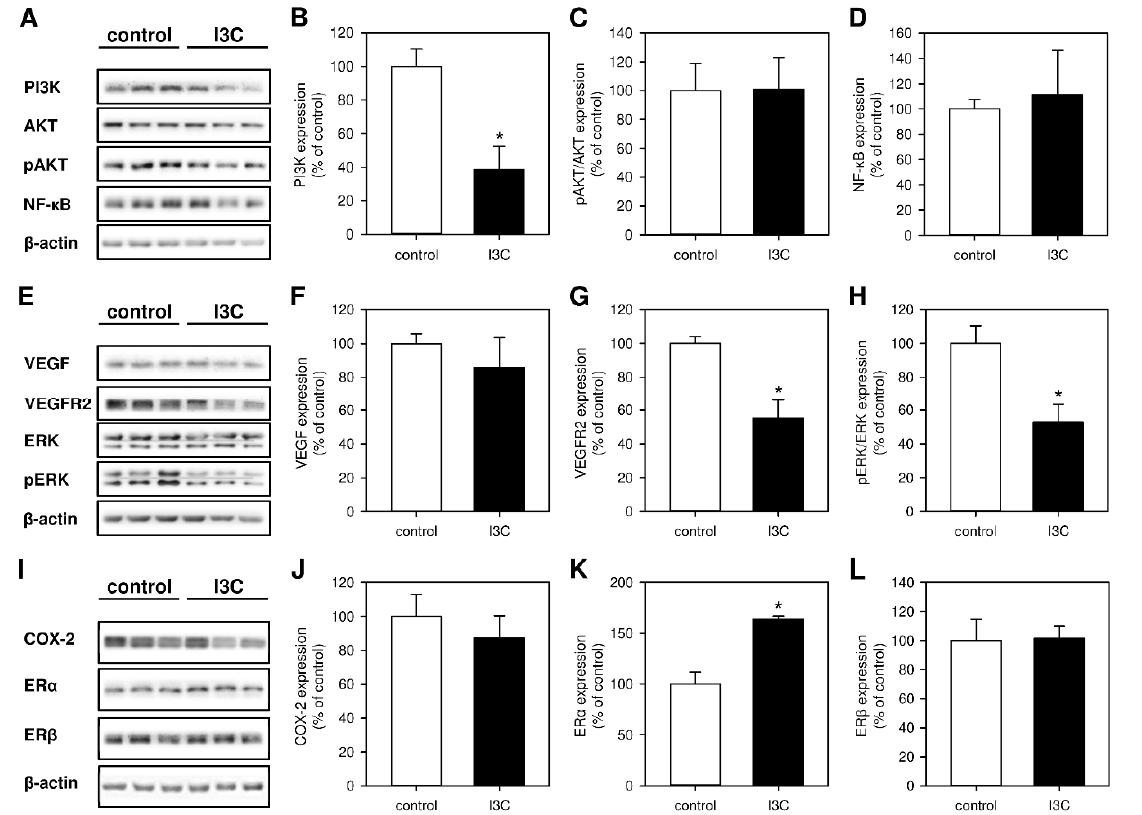
Figure 5. ( A ): Western blots showing the expression of PI3K, AKT, pAKT, NF‑kB and β ‑actin in endometriotic lesions on day 7 after transplantation of uterine tissue samples to the abdominal wall of vehicle‑treated control and I3C‑treated BALB/c mice. ( B – D ): Expression (% of control) of PI3K ( B ), pAKT/AKT ( C ) and NF‑kB ( D ) in endometriotic lesions of vehicle‑treated control (white bars; n = 3) and I3C‑treated BALB/c mice (black bars; n = 3). Mean ± SEM. * p < 0.05 vs. control. ( E ): Western blots showing the expression of VEGF, VEGFR2, ERK, pERK, and β ‑actin in endometriotic lesions on day 7 after transplantation of uterine tissue samples to the abdominal wall of vehicle‑treated con‑ trol and I3C‑treated BALB/c mice. ( F – H ): Expression (% of control) of VEGF ( F ), VEGFR2 ( G ) and pERK/ERK ( H ) in endometriotic lesions of vehicle‑treated control (white bars; n = 3) and I3C‑treated BALB/c mice (black bars; n = 3). Mean ± SEM. * p < 0.05 vs. control. ( I ): Western blots showing the expression of COX‑2, ER α , ER β and β ‑actin in endometriotic lesions on day 7 after transplantation of uterine tissue samples to the abdominal wall of vehicle‑treated control and I3C‑treated BALB/c mice. ( J – L ): Expression (% of control) of COX‑2 ( J ), ER α ( K ) and ER β ( L ) in endometriotic lesions of vehicle‑ treated control (white bars; n = 3) and I3C‑treated BALB/c mice (black bars; n = 3). Mean ± SEM. * p < 0.05 vs.